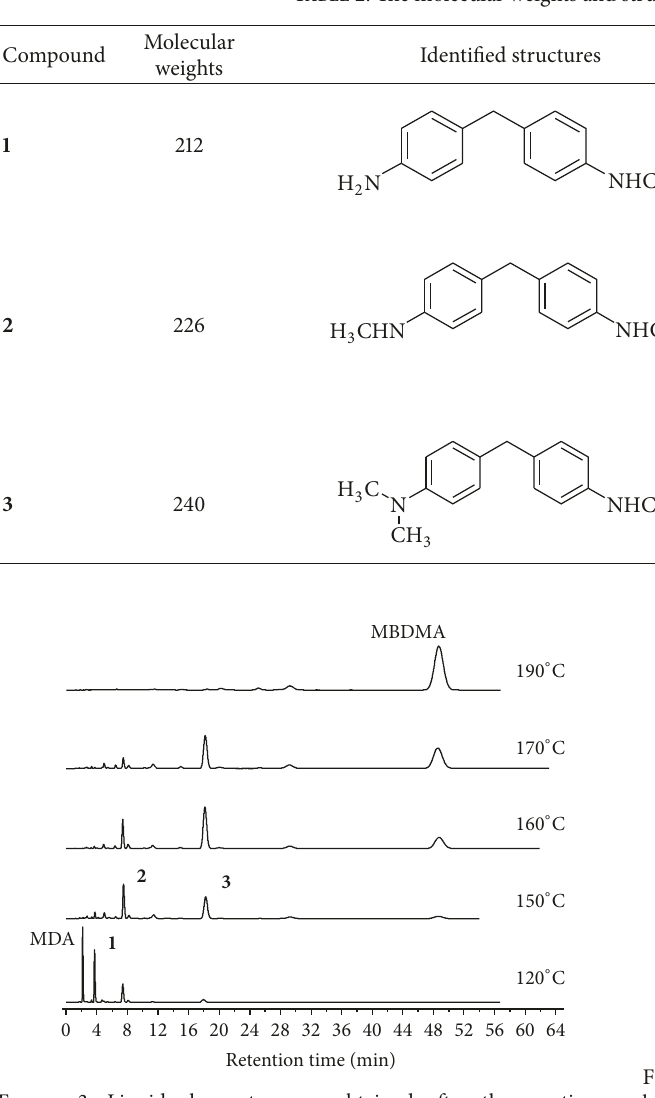
Table 2: The molecular weights and structures of by-products 1 , 2 , and 3 .